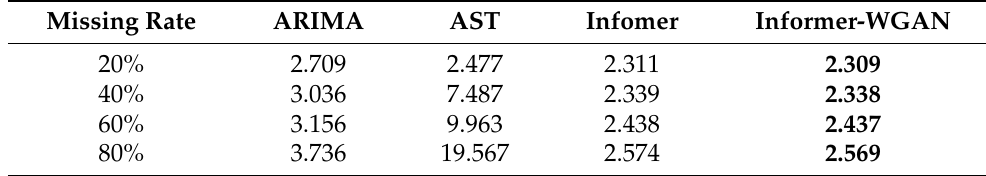
Table 7. The PRMSE (the smaller, the better) results of the informer-WGAN and other imputation results on ETTh1